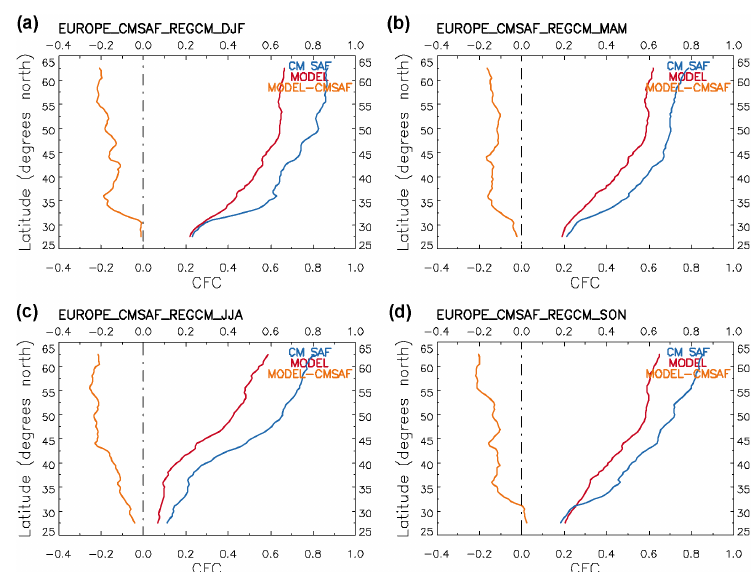
Figure 5. The same as Fig. 2 but for RegCM4 and CM SAF